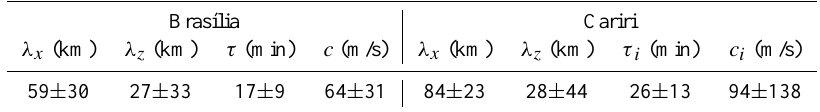
Fig. 2. Histograms of momentum flux and relative wave amplitude distributions in both sites, Cariri and Brasilia. Table 2. Averaged values of gravity wave parameters (horizontal wavelength, λ x ; vertical wavelength, λ z ; period, τ ; and phase velocity, c ) obtained for each site. In Cariri the averaged values represent intrinsic characteristics of GWs (subscript i ), while in Brasilia the obtained parameters are extrinsic due to lack of horizontal wind